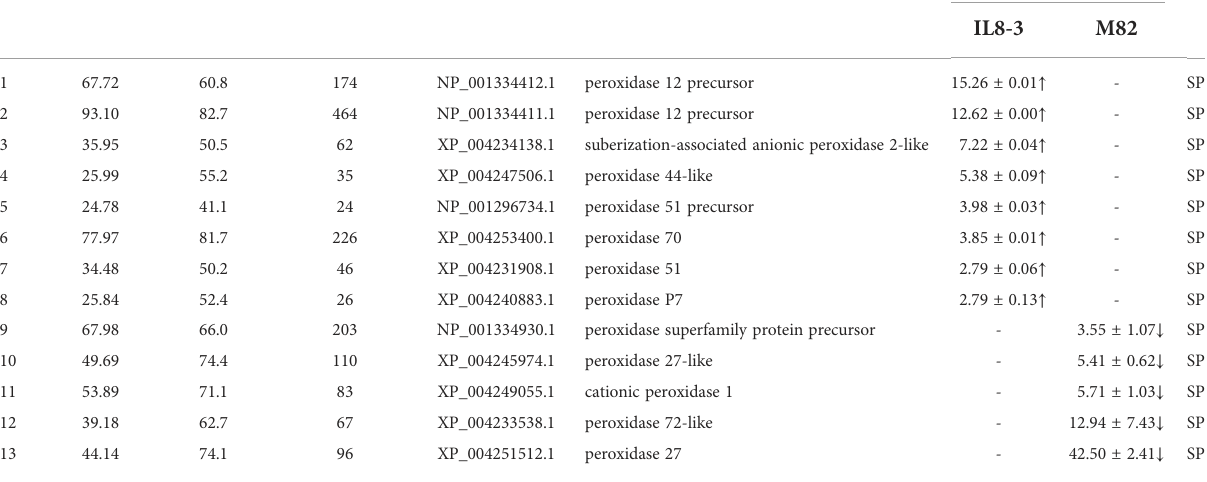
TABLE 3 Differentially abundant proteins (DAPs) belong to peroxidase family that identi fi ed from IL8-3 and M82 under salt stress. No. Protscore %Cov(95) Peptide(95%) Accession No.